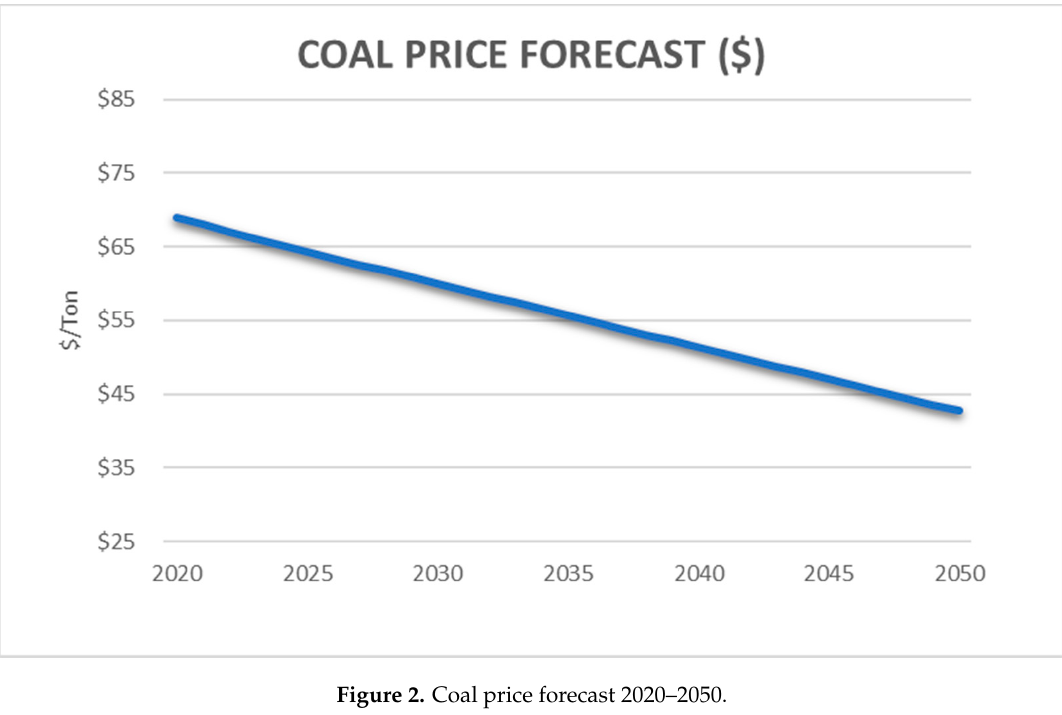
Figure 2. Coal price forecast 2020–2050.